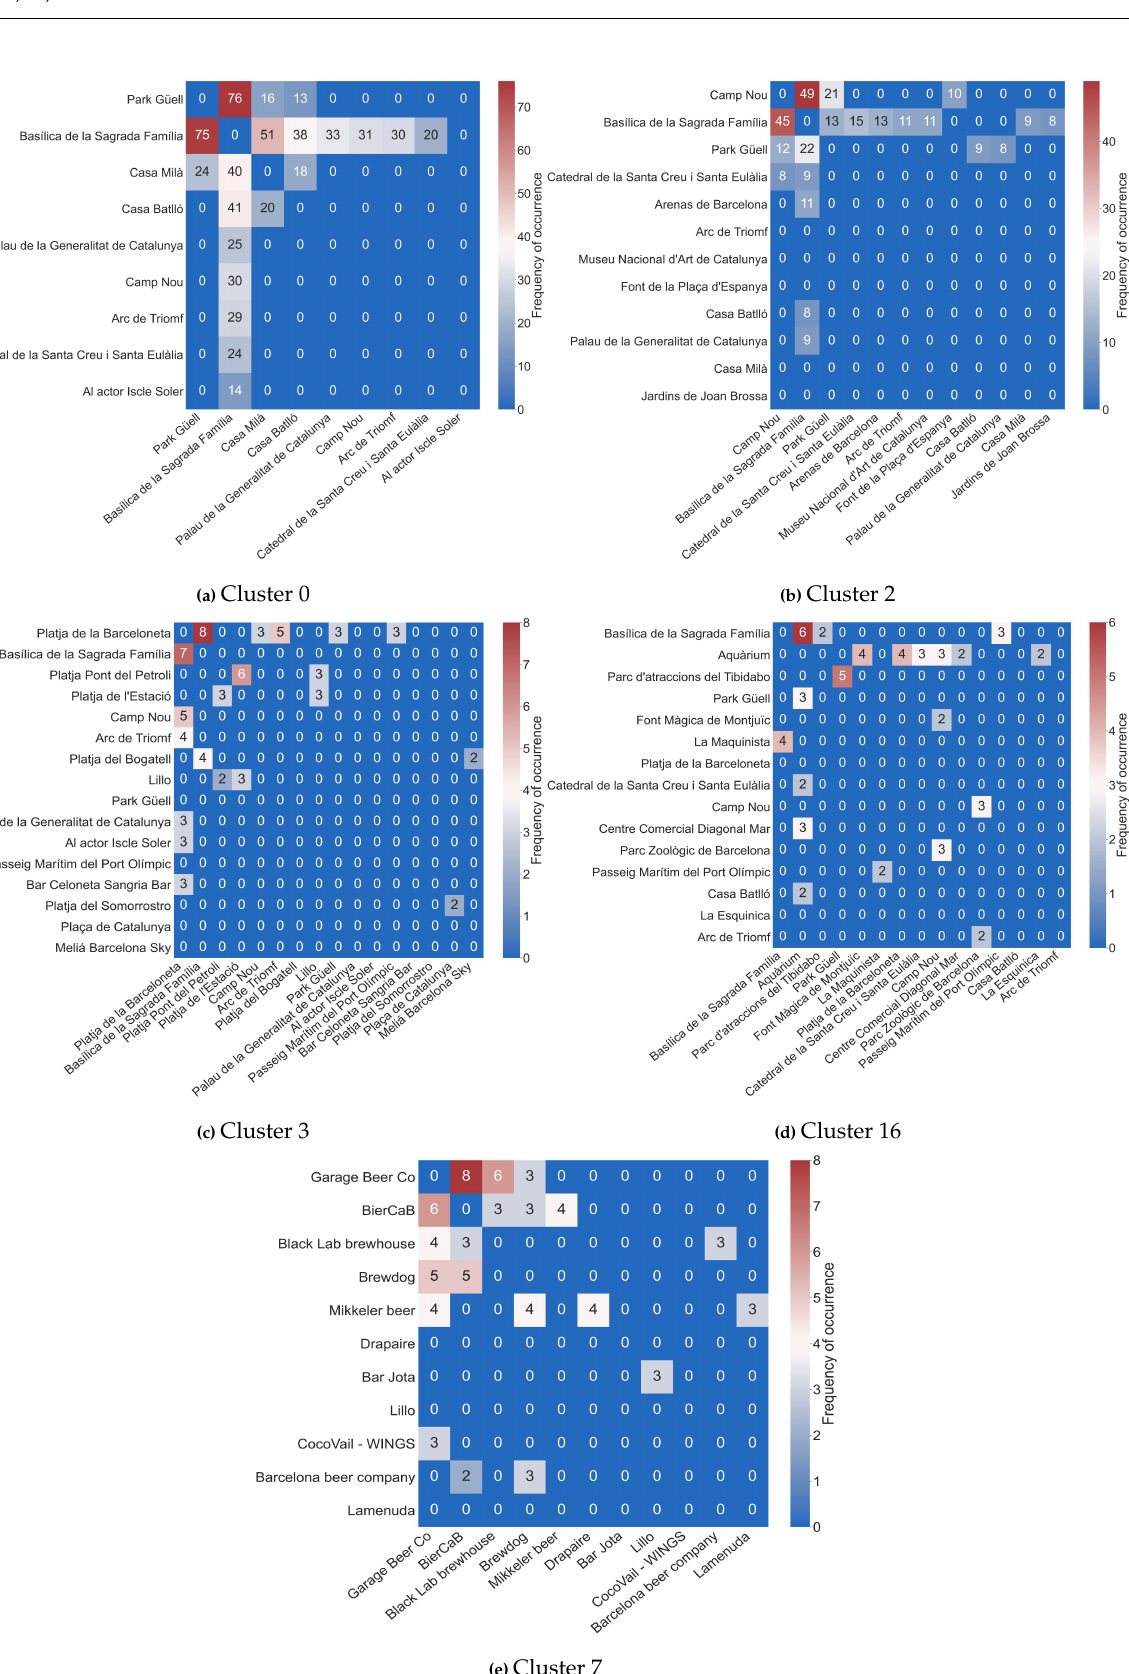
Figure 3. Mobility heat-maps for clusters 0, 2, 3, 16, and 7 representing bigrams with movement from left to